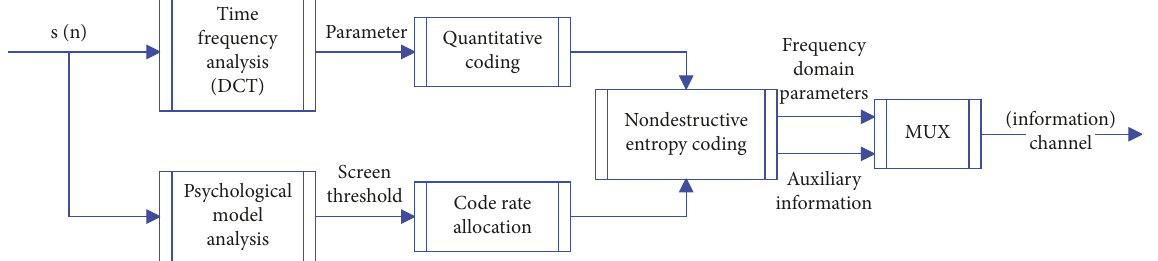
Figure 1: Block diagram of perceptual domain audio coding.